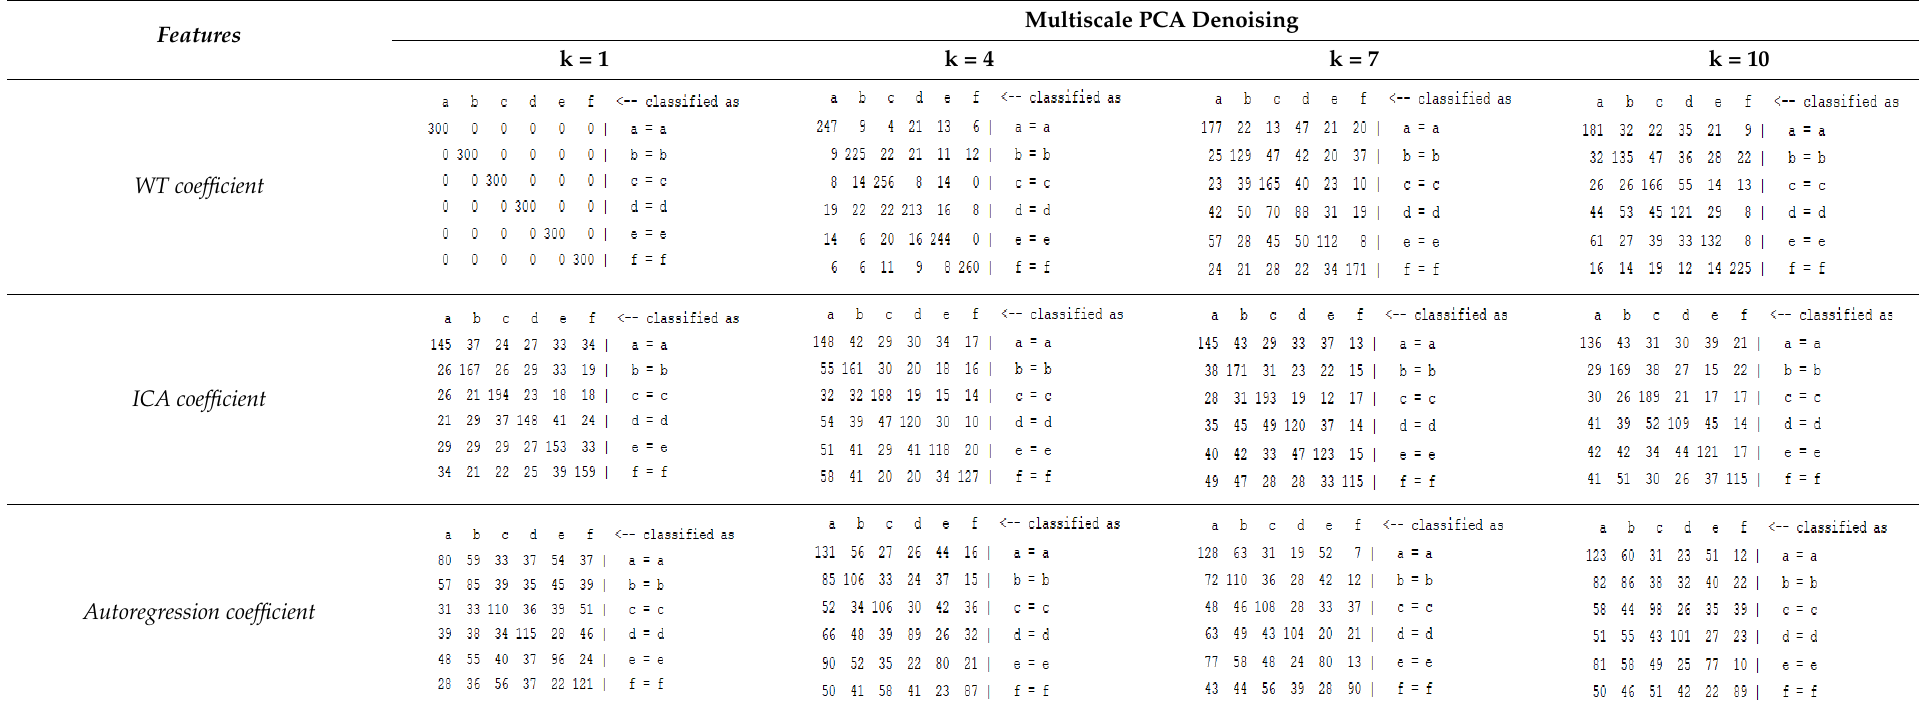
Table 2. The confusion matrix of the KNN method—denoising part.